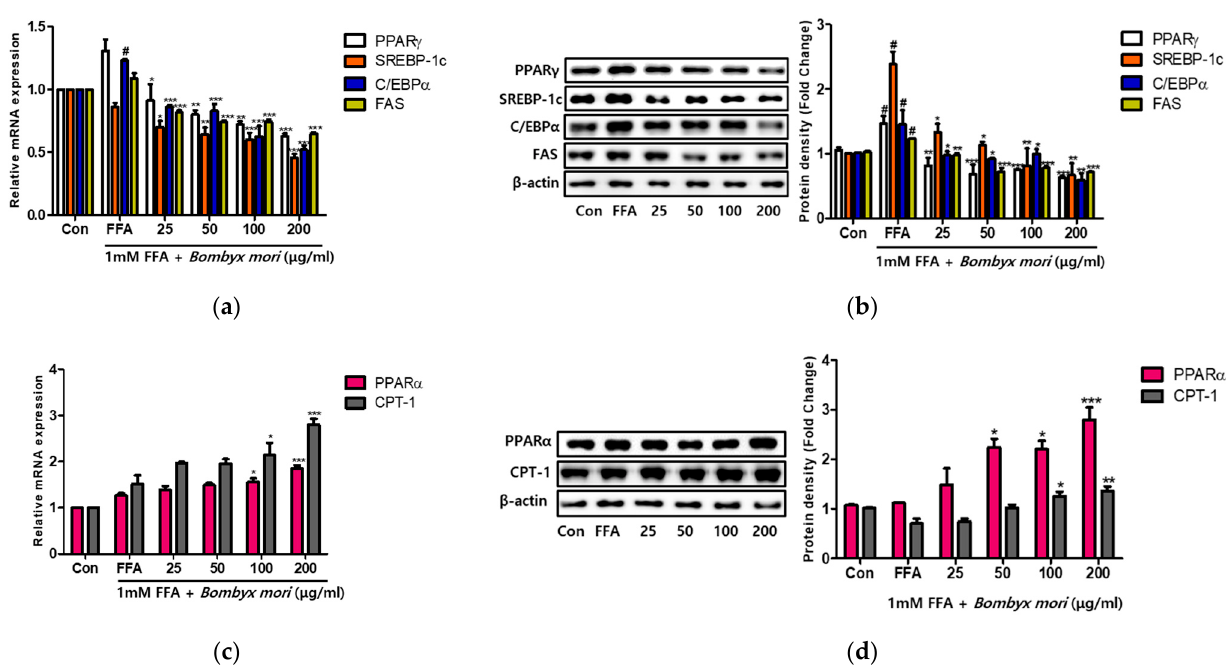
Figure 2. Effects of Bombyx mori (SW) on the expression of genes associated with lipogenesis and fatty acid oxidation in FFA-induced HepG2 cells. ( a ) Quantitative real-time PCR analysis of PPAR γ , C/EBP α , SREBP-1c, and FAS were normal- ized by β -actin as an internal control. ( b ) Expression of lipogenesis-related proteins. ( c ) The mRNA expression of PPAR α and CPT-1 quantified by real-time PCR and normalized by β -actin as an internal control. ( d ) Immunoblot analysis of PPAR α and CPT-1 levels and quantification. PPAR γ , peroxisome proliferator-activated receptor gamma; C/EBP α , CCAAT/enhancer-binding protein alpha; SREBP-1c, sterol regulatory element-binding protein 1-c; FAS, fatty acid syn- thase; PPAR α , peroxisome proliferator-activated receptor alpha; CPT-1, carnitine palmitoyltransferase 1. The results of three independent experiments are represented the means ± SE. # p < 0.05 vs. Control (Con); * p < 0.05, ** p < 0.01, and *** p < 0.001 vs. FFA.